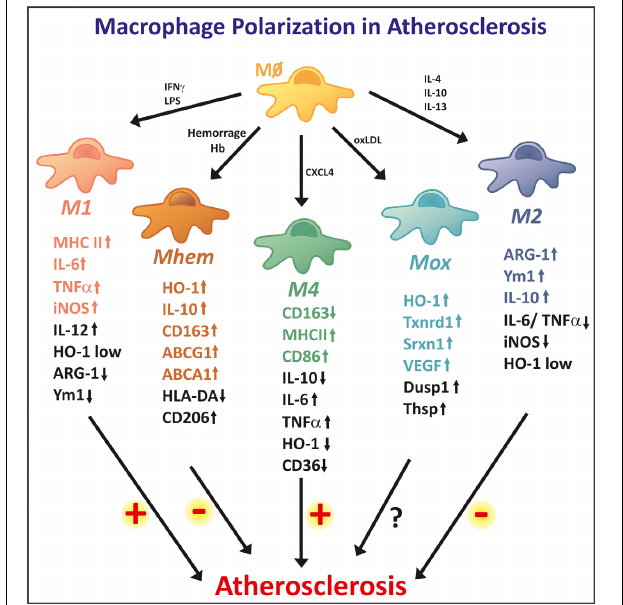
FIGURE 3 | High macrophage plasticity in atherosclerosis. In the atherosclerotic plaque, macrophages differentiate into different phenotypes. The two extreme phenotypes are represented by M1 and M2 macrophages. M1 macrophages show strong pro-inflammatory properties, thus potentially being involved in lesion progression. M1 macrophages show high expression levels of iNOS, MHCII, and inflammatory cytokines, such as IL-6 and TNF-a. M2 macrophages are considered anti-inflammatory and are involved in tissue repair and remodeling. M2 specific markers are Arginase 1, Ym1, and IL-10. The M2 phenotype is reported as anti-atherogenic. In addition, several other macrophage phenotypes are observed in the atherosclerotic plaque. Mhem macrophages originate as a consequence of intraplaque hemorrhage and are endowed with high Hb handling ability. These anti-atherogenic macrophages express high levels of the heme-degrading enzyme HO-1 and the Hp-Hb scavenger receptor CD163. Additionally, Mheme macrophages express the cholesterol exporters ABCA1 and ABCG1, thus efficiently activating reverse cholesterol efflux. Mox macrophages are generated upon oxidized phospholipid stimulation. They show anti-oxidant properties, as they express genes involved in the anti-oxidant responses such as HO-1, Txnrd1, and Srxn1. Their potentially athero-protective effect still needs to be demonstrated. M4 macrophages differentiate in response to the chemo-attractant CXCL4, thus showing pro-inflammatory and pro-atherogenic effects. These macrophages express low levels of CD163 and high levels of MHCII and CD86. M1 and M4 macrophages promote, while M2 and Mhem macrophages counteract foam cell formation, thus having opposite effect on atherosclerosis